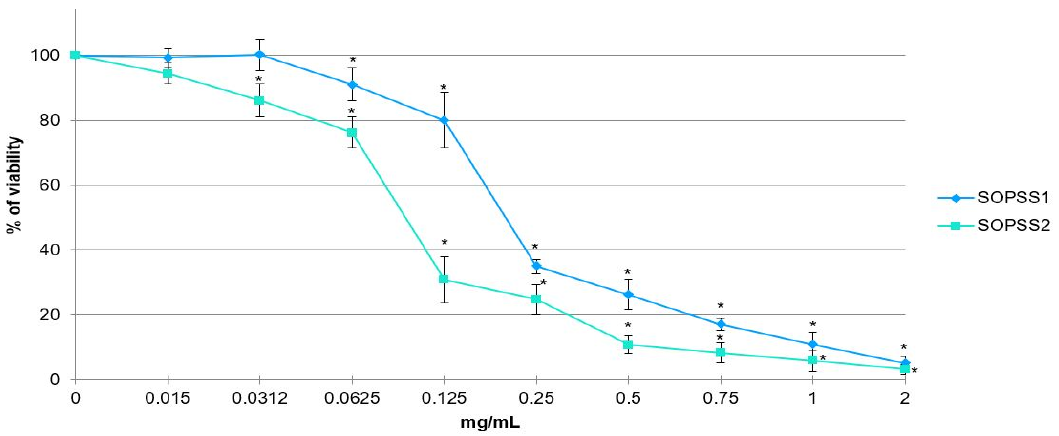
Figure 6. MTT assay results of transgenic SOPSS S. obtusifolia root extracts on human acute lymphoblastic leukemia (NALM6) cells. The cells were incubated with root extracts at a concentration range of 0.015–2 mg/mL for 24 h. Data are presented as the mean ± SD of triplicate independent experiments. * p < 0.05 SOPSS1, SOPSS2 vs. untreated cells.